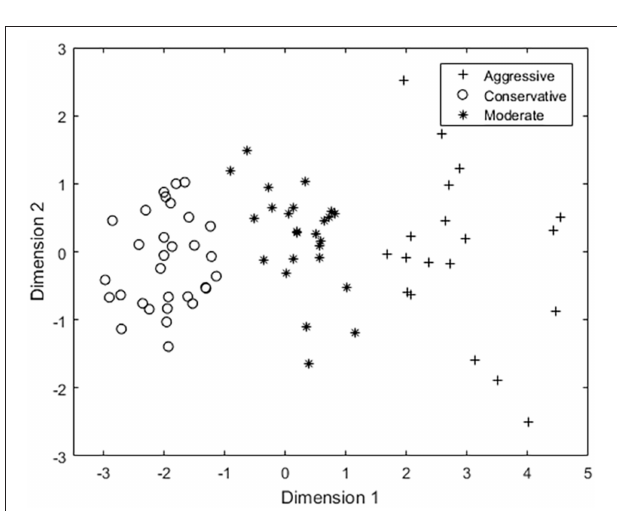
FIGURE 4 | Results of K-means based on the driving